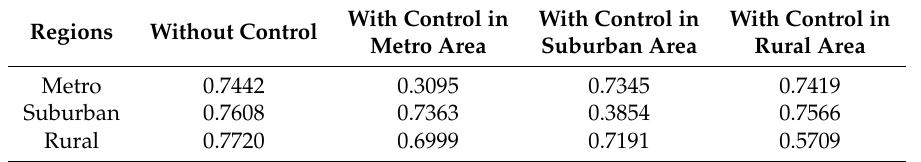
Table 9. Final population size when controlling MRSA one at a time when the regions are connected. With Control in With Control in With Control in Regions Without Control Metro Area Suburban Area